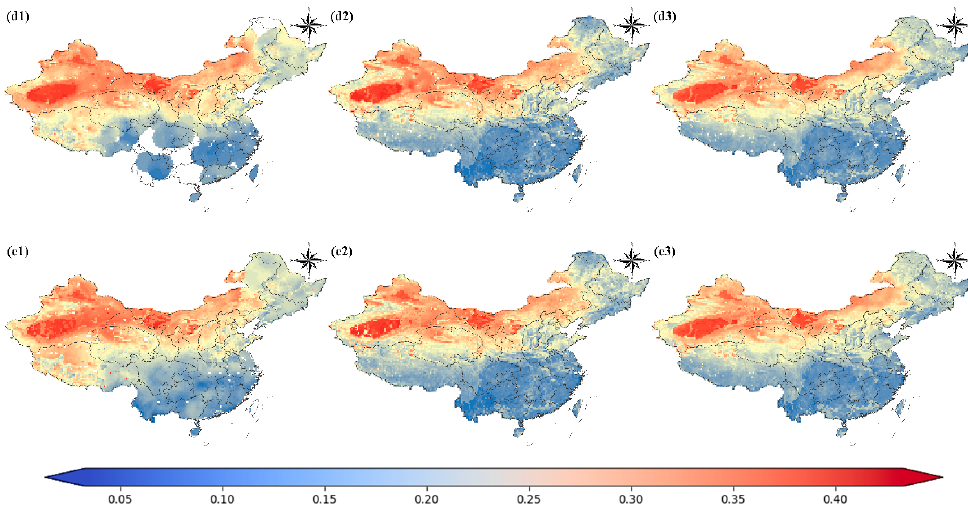
Figure 2. a1 , a2 , and a3 are original CCI SM in June 1990, July 2000, and August 2010, respectively; b1 , b2 , and b3 are gap-filled CCI SM using FNN method in those months; c1 , c2 , and c3 are gap-filled CCI SM using RF method in those months; d1 , d2 , and d3 are gap-filled CCI SM using OK method in those months; e1 , e2 , and e3 are gap-filled CCI SM using GLM method in those months. The white areas represent gaps of CCI SM. The color bar ranged from the lowest 0.033 to the highest 0.433.